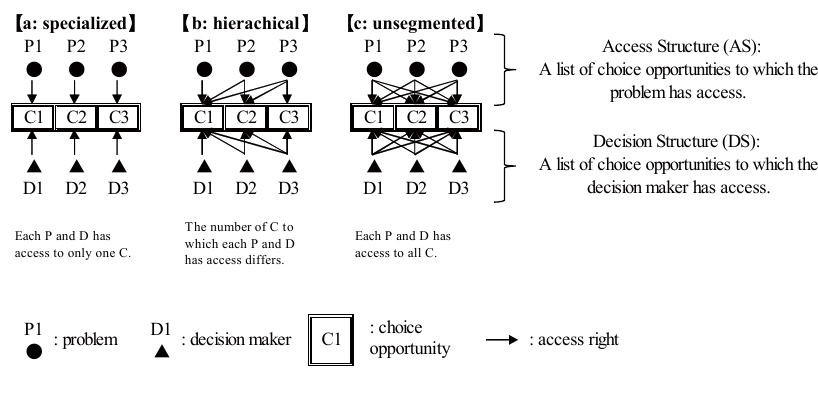
Figure 2. Access structures and decision